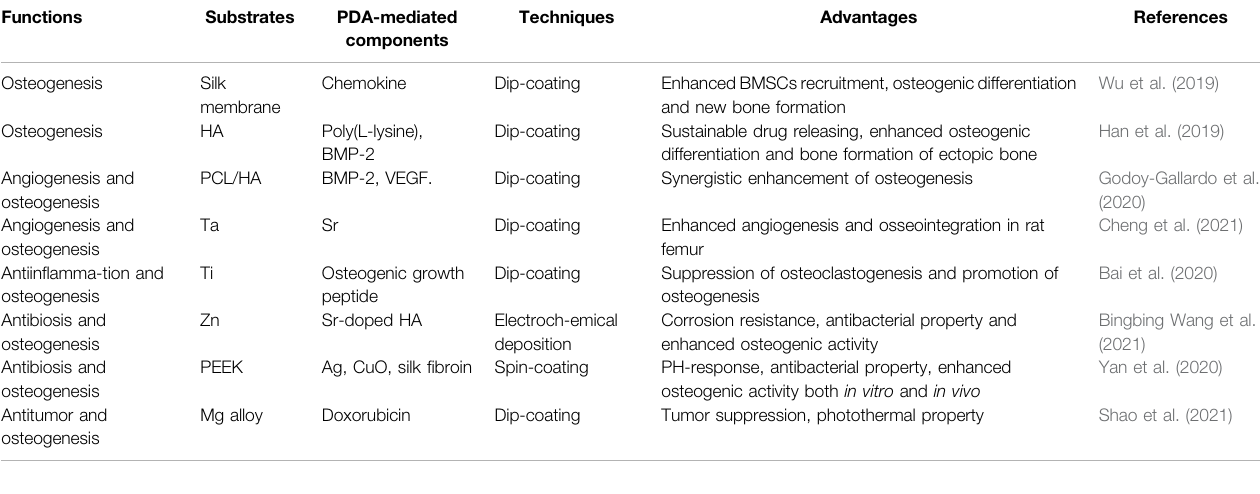
TABLE 4 | Synergistic enhancement of multiple components and functions for new bone formation.